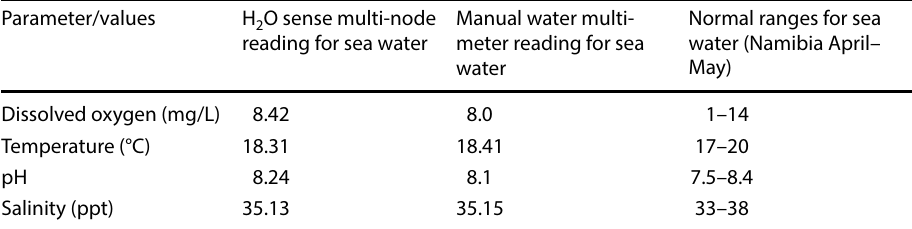
Parameter/values H